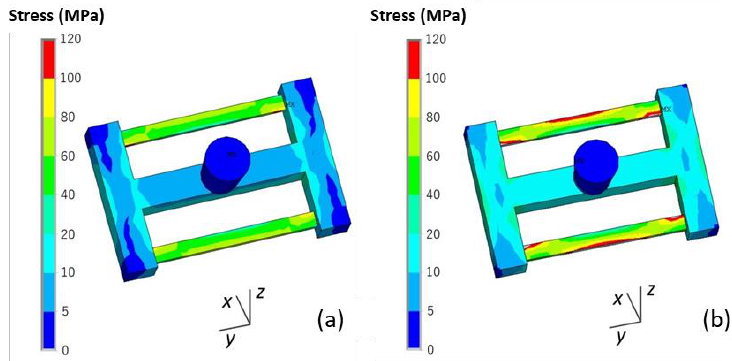
Figure 15. Comparison of the von Mises stress of the castings using the ( a ) skeletal sand mold and ( b ) traditional sand mold at shakeout.